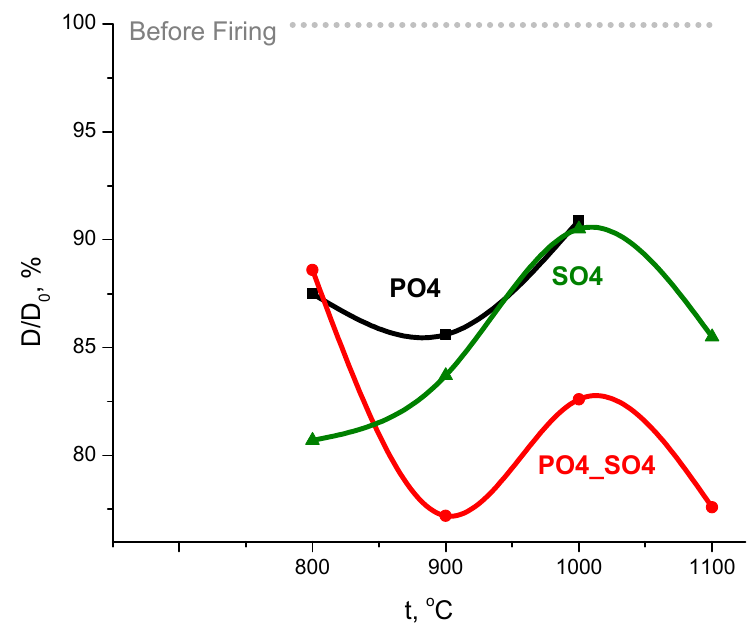
Figure 10. Temperature dependence of diameter of ceramic samples after firing.